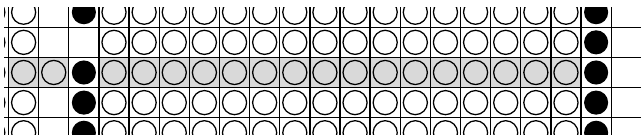
Figure 22. BLACK wins.